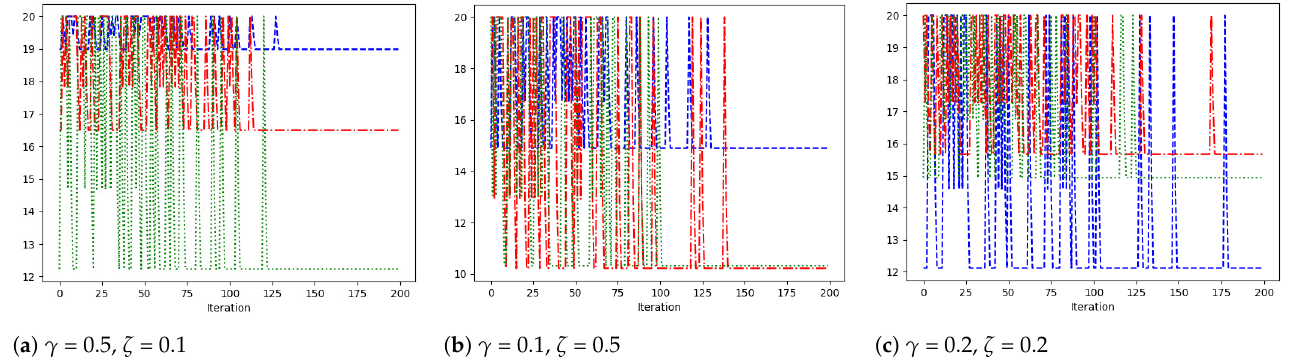
Figure 8. Convergence behaviour of average CP utility (7) for multiple user populations (small (blue), medium (red), large (green)).